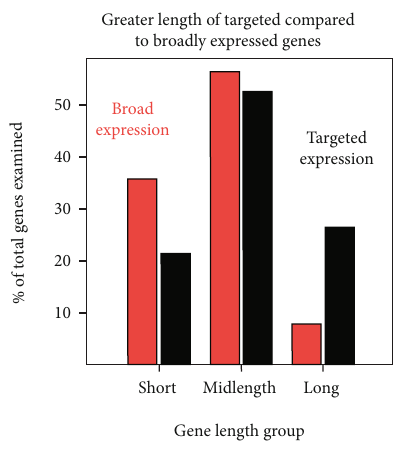
Figure 1: Proportion of short, midlength, and long genes in the databases of broadly expressed (red) and tissue-targeted genes (black). Note that the proportion of long genes is higher in the tissue-targeted database genes while the proportion of short genes is higher in broadly expressed